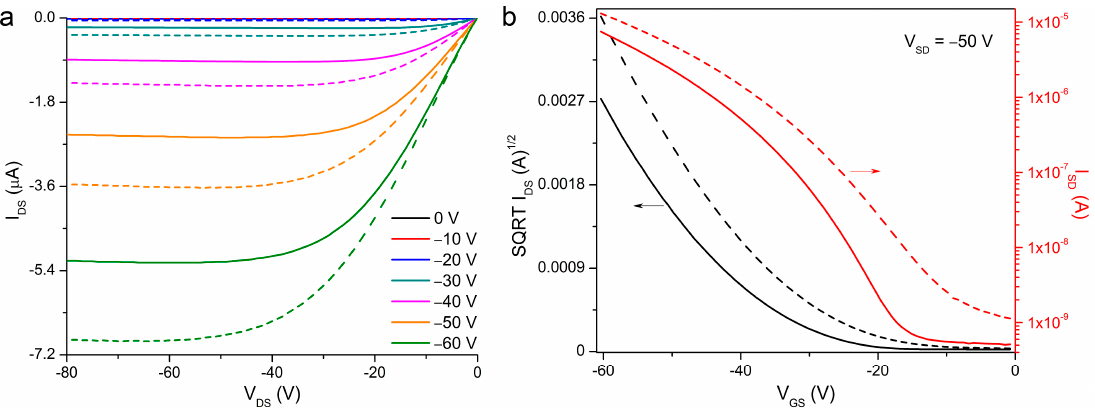
Figure 3. Example ( a ) output and ( b ) transfer curves for 4 blended with poly(styrene) Solid lines represent data obtained in vacuum (P < 0.1 Pa), dashed lines represent data obtained in air. Data in ( b ) is plotted for both the square root (black lines) and log (red lines) of the current.